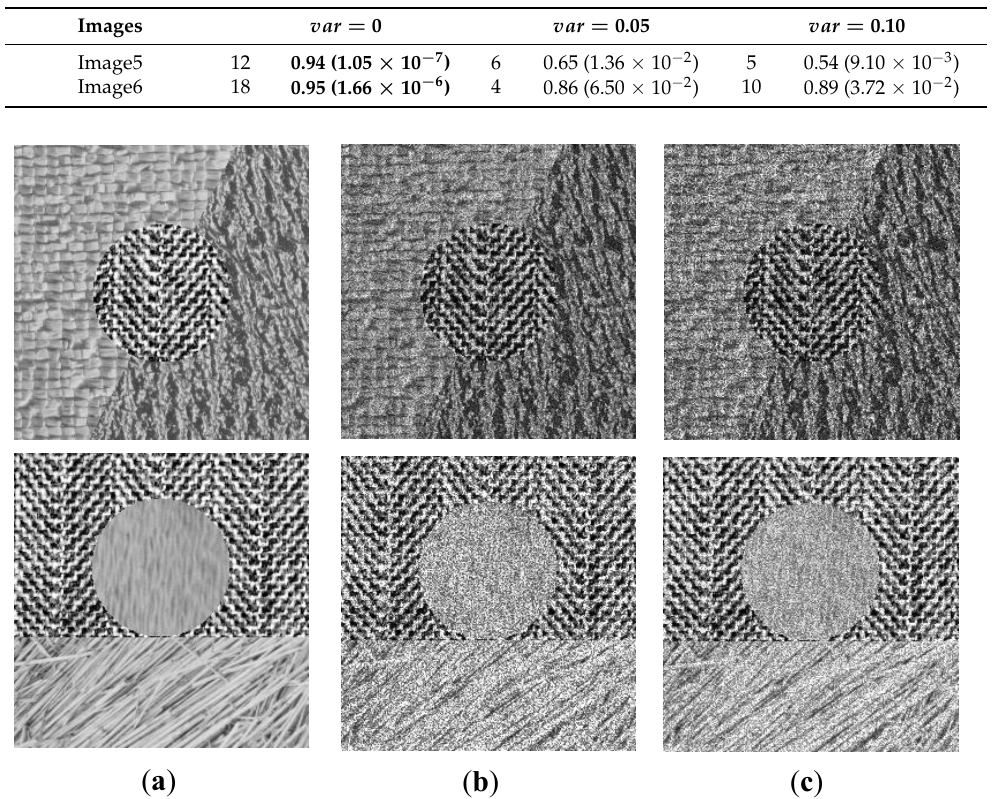
Table 2. Mean and variance of ARI on texture images with speckle noise.